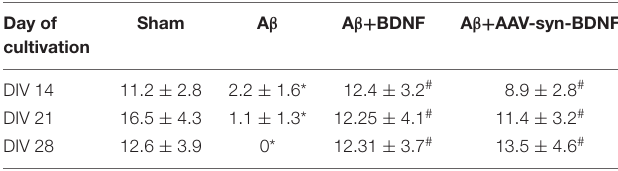
TABLE 4 | Average number of connections in a hub in primary hippocampal neural networks on different days of development in vitro. Day of cultivation